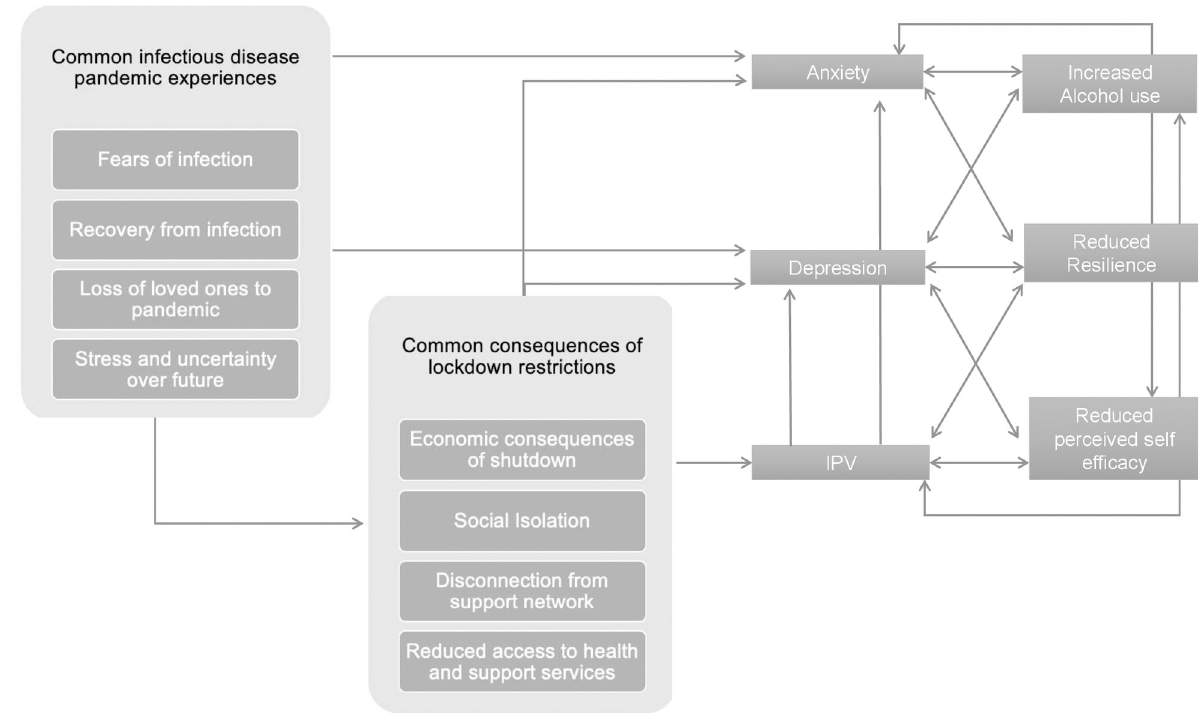
Fig 1. Conceptual model depicting pathways between an infectious disease pandemic, stay-at-home orders, mental health and behavioral sequelae.